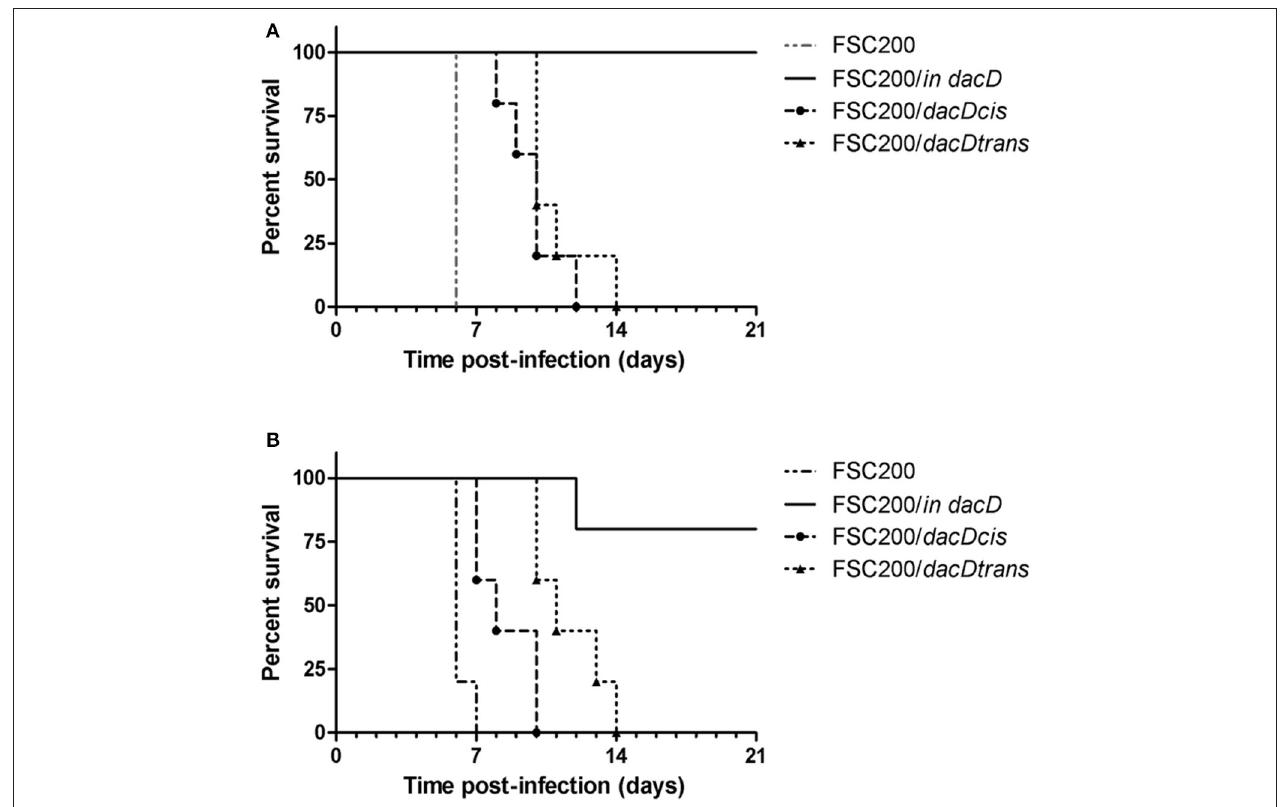
FIGURE 3 | Survival of mice after subcutaneous infection with FSC200/ in dacD , complemented and wild-type strains. Mice were infected with a dose of 10 cfu/mouse (A) and 50 cfu/mouse (B) and were observed for 21 days and the deaths were